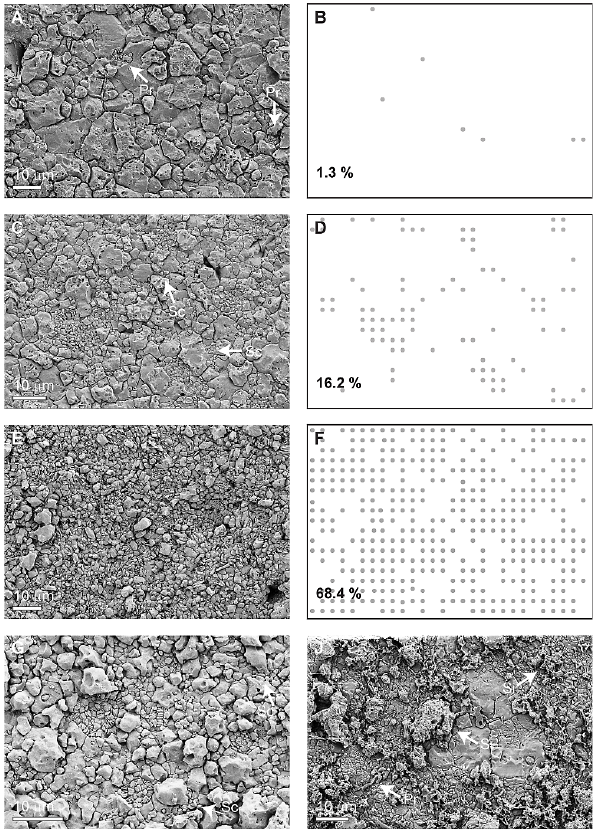
Fig. 5. Ultrafacies of late Norian and Rhaetian lime mudstones from Pignola-Abriola and Pizzo Mondello, as seen under the SEM. All samples of this figure were prepared with polishing and etch- ing. In (A–E) , SEM images are compared with the results of point counting. Three examples with scarce, abundant and dominant Prin- siosphaera are shown. (A) and (B ) Sample from the Mockina biden- tata conodont zone, late Norian of Pizzo Mondello, 9.71m in Fig. 2. Note large microspar crystals with pits highlighted by etch- ing. Pr= Prinsiosphaera . (C) and (D ) Sample from the Parvigondo- lella andrusovi–Misikella hernsteini conodont zone, late Norian of Pizzo Mondello, 23.74m in Fig. 2. In this sample, complete speci- mens of Prinsiosphaera are associated with isolated scales (Sc) of disaggregated Prinsiosphaera “calcispheres”. (E) and (F) Sample from the Misikella ultima conodont zone, Rhaetian of Pizzo Mon- dello, 54.5m in Fig. 2. Prinsiosphaera is here the dominant rock component. Single specimens are compacted and indistinguishable. Note the fine microspar, with crystals always smaller than 10µm. (G) Sample from the Mockina bidentata conodont zone, late No- rian of Pignola-Abriola, 23.7m in Fig. 3. Complete specimens of Prinsiosphaera with well-developed piles of scales are here asso- ciated with isolated scales (Sc), often engulfed by the surrounding microspar. (J) Sample from the Misikella posthernsteini conodont zone, Rhaetian of Pignola-Abriola, 52.1m in Fig. 3. Silification formed in this sample’s patches of amorphous silica or chert (Si) in interstitial positions that stick out of the sample surface after etch- ing. The large, subrounded patch in the center may be a substituted radiolarian test. Prinsiosphaera (Pr) are still well recognizable and some microspar is also